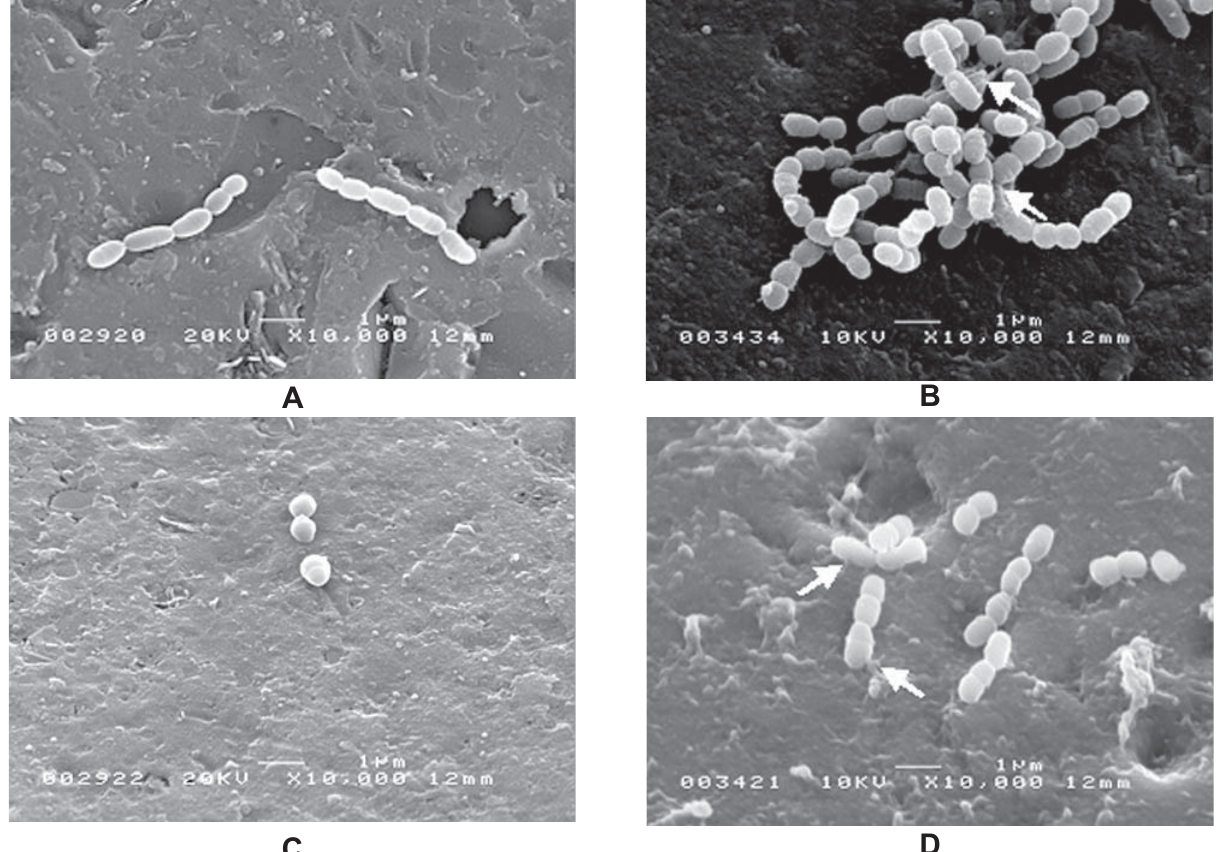
Figure 3- Scanning electron microscope micrographs of S. mutans cells treated with crude aqueous Piper betle L. extract (CA) on the glass beads in the absence and presence of 1% sucrose. A: S. mutans cells grown in the absence of 1% sucrose and presence of 2 mg mL -1 (cid:6)(cid:9)(cid:23)(cid:7)(cid:17)(cid:11)(cid:18)(cid:7)(cid:6)(cid:19)(cid:22)(cid:6)(cid:4)(cid:3)(cid:9)(cid:21)(cid:9)(cid:24)(cid:6)(cid:11)(cid:7)(cid:6)(cid:25)(cid:26)(cid:27)(cid:26)(cid:26)(cid:26)(cid:23)(cid:6)(cid:10)(cid:11)(cid:2)(cid:5)(cid:3)(cid:28)(cid:18)(cid:11)(cid:7)(cid:3)(cid:20)(cid:5)(cid:29)(cid:6)(cid:30)(cid:8)(cid:9)(cid:17)(cid:9)(cid:6)(cid:21)(cid:9)(cid:17)(cid:9)(cid:6)(cid:5)(cid:20)(cid:7)(cid:6)(cid:10)(cid:11)(cid:5)(cid:15)(cid:6)(cid:18)(cid:9)(cid:31)(cid:31)!(cid:6)!(cid:9)(cid:9)(cid:5)(cid:6)(cid:11)(cid:24)(cid:8)(cid:9)(cid:17)(cid:3)(cid:5)(cid:2)(cid:6)(cid:7)(cid:20)(cid:6) the glass surface and they appeared to be in dividing state. B: S. mutans cells were grown in the presence of 1% sucrose and 2 mg mL -1 (cid:6)(cid:9)(cid:23)(cid:7)(cid:17)(cid:11)(cid:18)(cid:7)(cid:6)(cid:4)(cid:3)(cid:9)(cid:21)(cid:9)(cid:24)(cid:6)(cid:11)(cid:7)(cid:6)(cid:10)(cid:11)(cid:2)(cid:5)(cid:3)(cid:28)(cid:18)(cid:11)(cid:7)(cid:3)(cid:20)(cid:5)(cid:6)(cid:25)(cid:26)(cid:27)(cid:26)(cid:26)(cid:26)(cid:23)(cid:29)(cid:6)(cid:30)(cid:8)(cid:9)(cid:17)(cid:9)(cid:6)(cid:21)(cid:9)(cid:17)(cid:9)(cid:6)(cid:4)(cid:9)(cid:17)(cid:15)(cid:6)(cid:14)(cid:9)(cid:21)(cid:6)(cid:18)(cid:9)(cid:31)(cid:31)!(cid:6)(cid:11)(cid:24)(cid:8)(cid:9)(cid:17)(cid:3)(cid:5)(cid:2)(cid:6)(cid:7)(cid:20)(cid:6)(cid:7)(cid:8)(cid:9)(cid:6)(cid:2)(cid:31)(cid:11)!!(cid:6)!(cid:13)(cid:17)(cid:14)(cid:11)(cid:18)(cid:9)(cid:6)(cid:11)(cid:5)(cid:24)(cid:6)(cid:7)(cid:8)(cid:9)(cid:15)(cid:6) appeared to be in the dividing state. Fluffy extracellular surface appearance is also observed (arrow). C: S. mutans cells grown in the absence of 1% sucrose and presence of 4 mg mL -1 (cid:6)(cid:9)(cid:23)(cid:7)(cid:17)(cid:11)(cid:18)(cid:7)(cid:6)(cid:4)(cid:3)(cid:9)(cid:21)(cid:9)(cid:24)(cid:6)(cid:11)(cid:7)(cid:6)(cid:10)(cid:11)(cid:2)(cid:5)(cid:3)(cid:28)(cid:18)(cid:11)(cid:7)(cid:3)(cid:20)(cid:5)(cid:6)(cid:25)(cid:26)(cid:27)(cid:26)(cid:26)(cid:26)(cid:23)(cid:29)(cid:6)"(cid:9)(cid:21)(cid:9)(cid:17)(cid:6)(cid:18)(cid:9)(cid:31)(cid:31)!(cid:6)(cid:21)(cid:9)(cid:17)(cid:9)(cid:6) seen adhering to the surface compared to that in Figure 3A and they also appeared to be in dividing state. D: S. mutans cells grown in the presence of 1% sucrose and 4 mg mL -1 (cid:6)(cid:9)(cid:23)(cid:7)(cid:17)(cid:11)(cid:18)(cid:7)(cid:6)(cid:4)(cid:3)(cid:9)(cid:21)(cid:9)(cid:24)(cid:6)(cid:11)(cid:7)(cid:6)(cid:10)(cid:11)(cid:2)(cid:5)(cid:3)(cid:28)(cid:18)(cid:11)(cid:7)(cid:3)(cid:20)(cid:5)(cid:6)(cid:25)(cid:26)(cid:27)(cid:26)(cid:26)(cid:26)(cid:23)(cid:29)(cid:6)"(cid:9)(cid:21)(cid:9)(cid:17)(cid:6)(cid:18)(cid:9)(cid:31)(cid:31)!(cid:6)(cid:21)(cid:9)(cid:17)(cid:9)(cid:6)!(cid:9)(cid:9)(cid:5)(cid:6) adhering to the surface compared to that in Figure